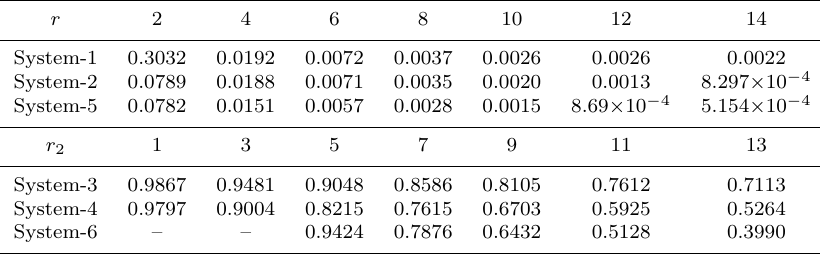
Table 3. Relative H 2 errors in Example 2.